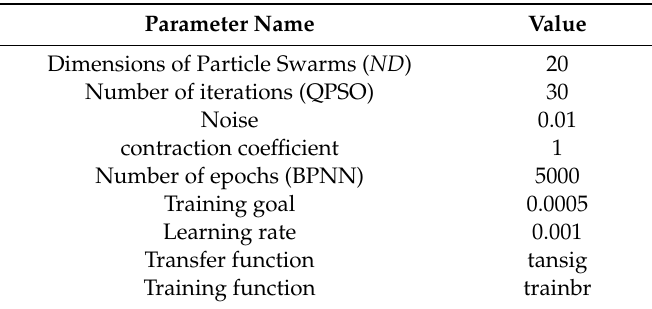
Table 6. Parameters setup for